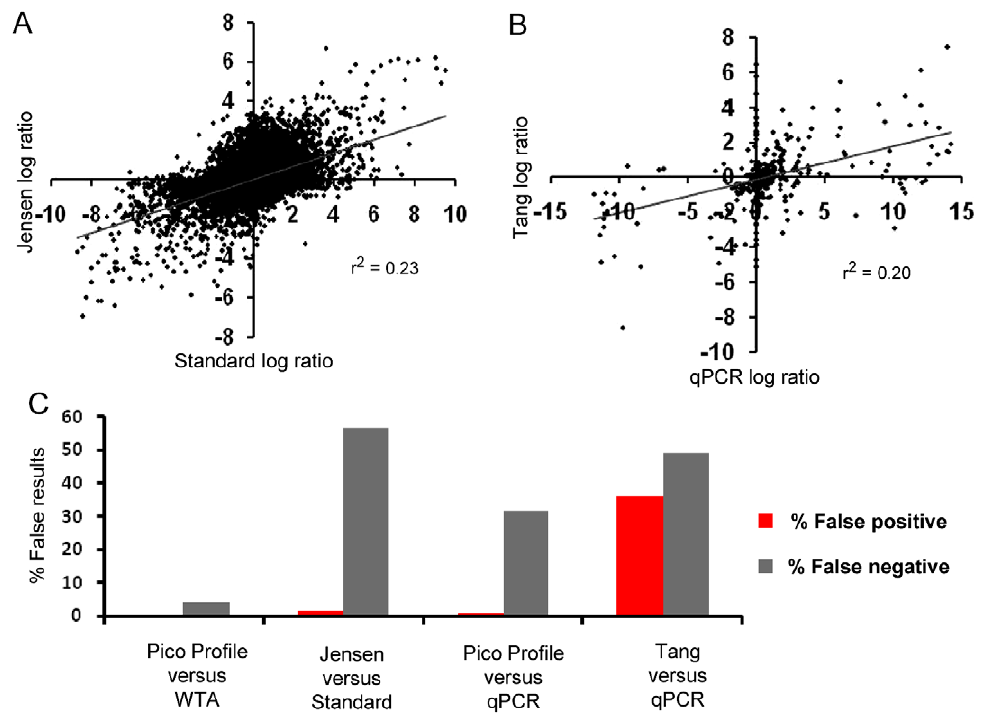
Figure 4. Comparison of Pico Profiling with formerly available profiling methods from small amounts of RNA. A , correlation of differential expression measured from 50 pg RNA versus 5 m g in Jensen’s data set. B , correlation of differential expression measured by sequencing versus qPCR in Tang’s data set. C , quantification of false positive and false negative rates for different expression profiling methods; from left to right: for Pico Profiling versus WTA from 25 ng, for 50 pg RNA versus 5 m g in Jensen’s data, for Pico Profiling versus qPCR, and for sequencing versus qPCR in Tang’s data set.